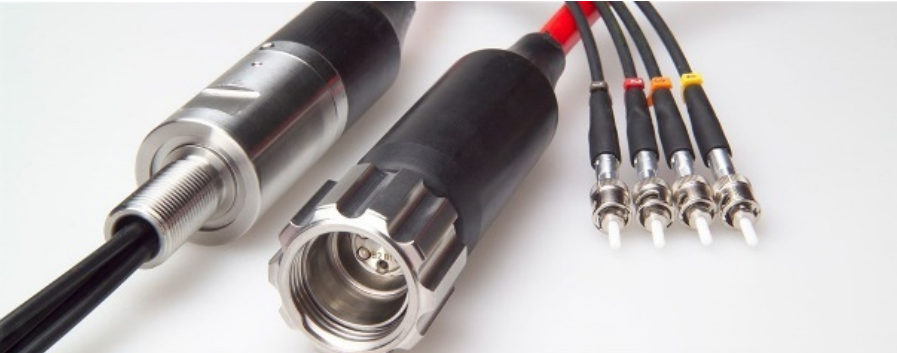
Figure 4. The OptoLink Fiber Optic Connector [38].